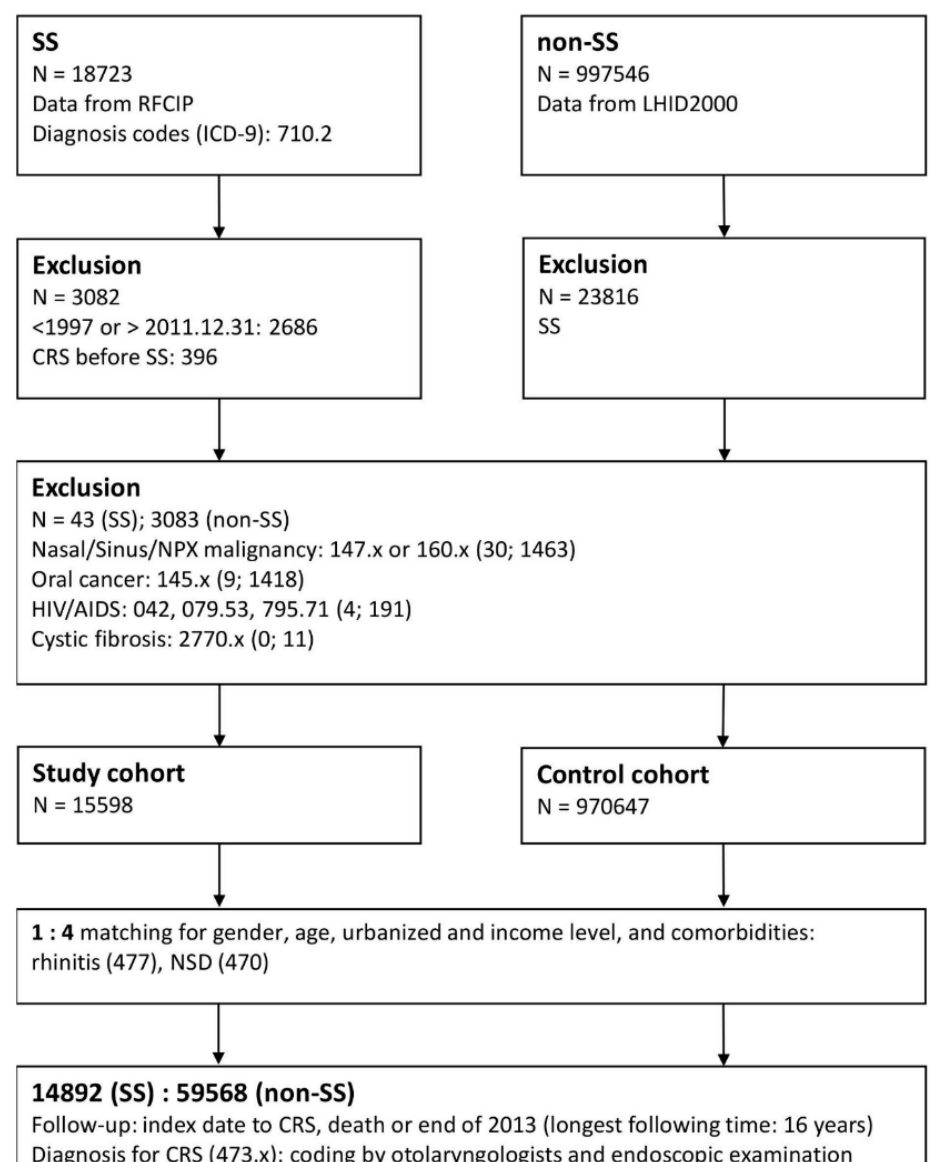
Figure 1. Enrollment flowchart of the study patients. Abbreviations: SS, Sjögren’s syndrome; RFCIP, Registry for Catastrophic Illness Patients; LHID2000, Longitudinal Health Insurance Database 2000; CRS, chronic rhinosinusitis; NPX, nasopharynx; HIV, human immunodeficiency virus; AIDS, acquired immune deficiency syndrome; NSD, nasal septal deviation.